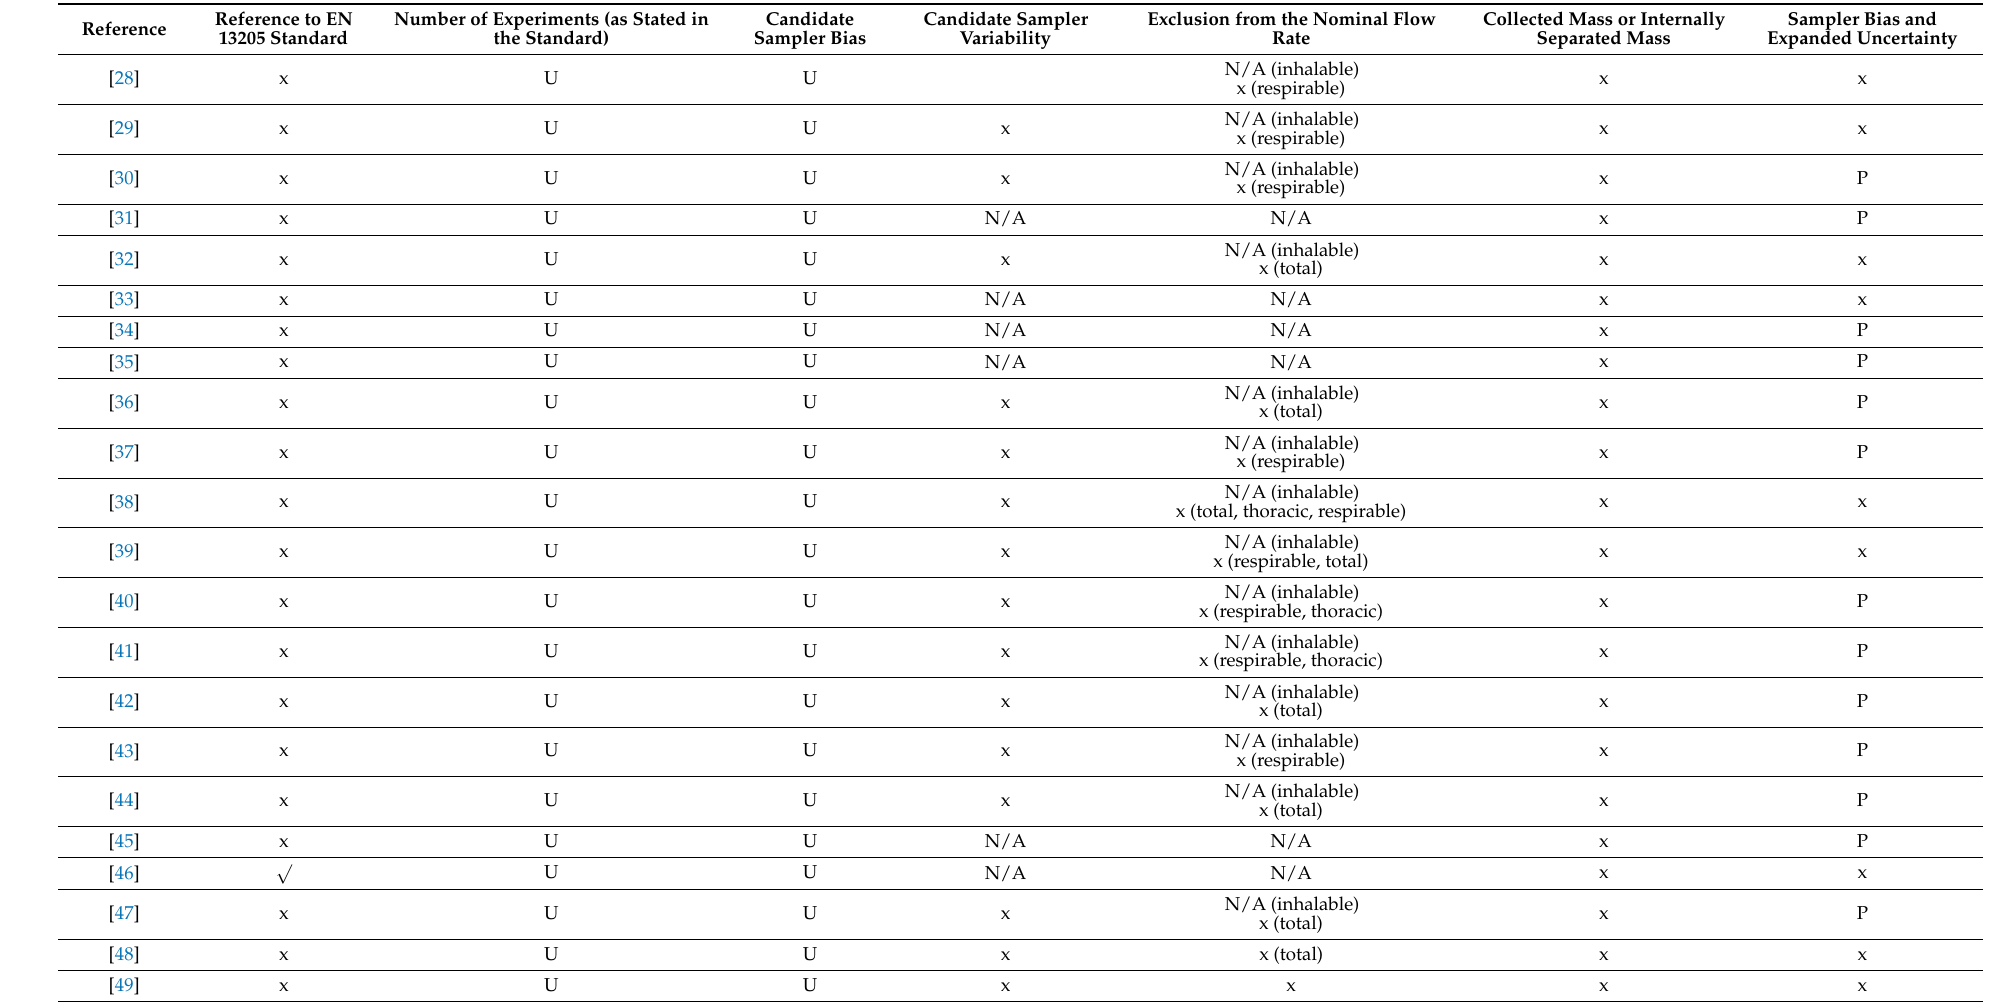
Table 4. Comparison of studies with requirements of EN 13205:5